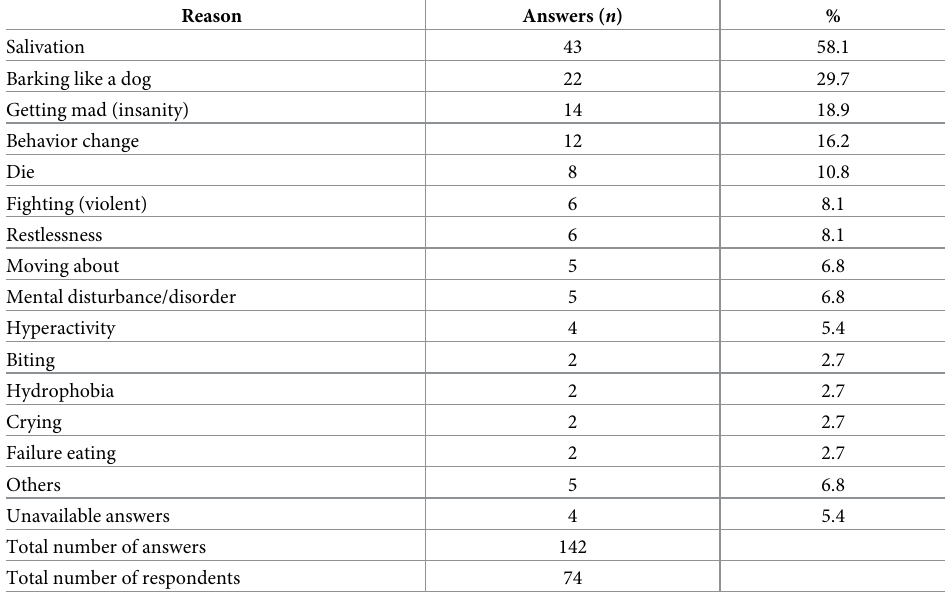
Table 7. Answers about symptoms of rabies in humans (multiple